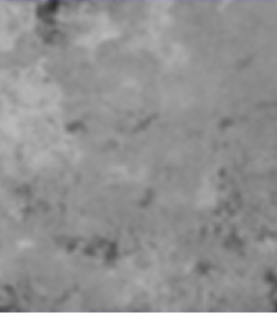
Figure 17. The original image of the unaffected area in the yellow border.